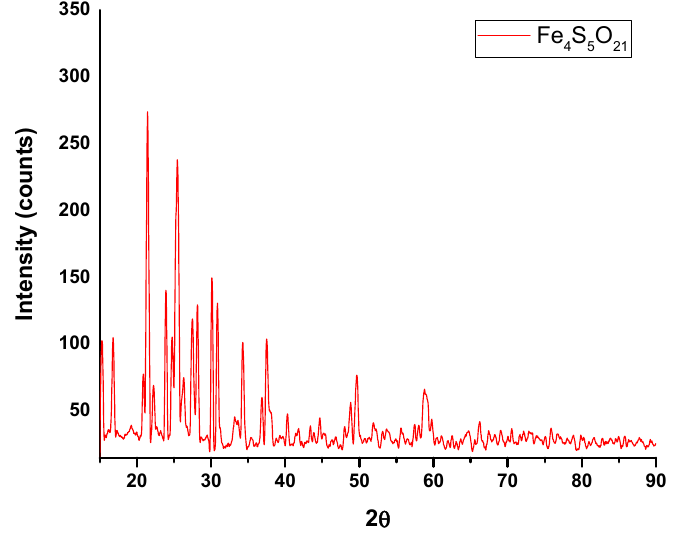
Figure 6. X-ray diffraction of the MS-ION powder.